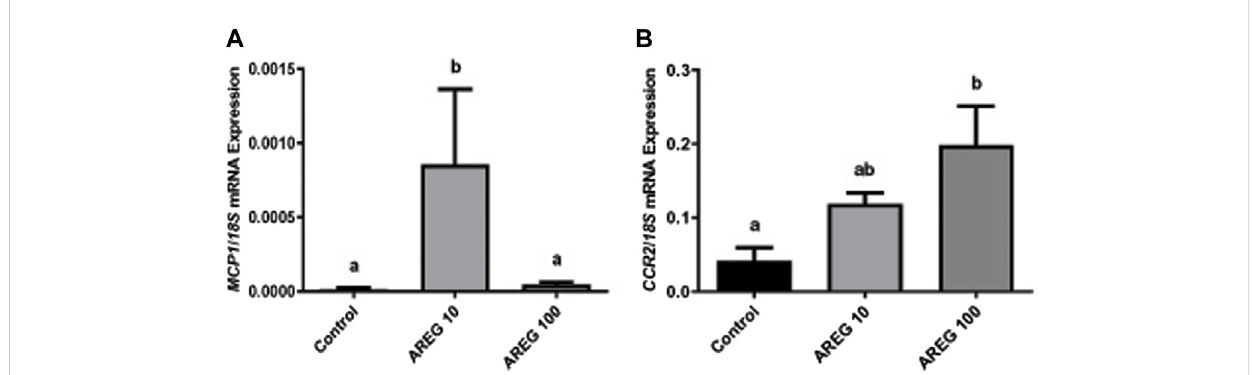
FIGURE 2 The mRNA expression of MCP1 and CCR2 signi fi cantly increased within the COC in the presence of recombinant AREG. Normalized MCP1 [Panel (A) ],and CCR2 [Panel (B) ],mRNAexpressionlevels(mean±SEM,n=5 – 6COCspergroup)withintheCOCafter3 hofcultureinthepresenceorabsence of recombinant AREG (10 or 100 ng/mL), assessed by qRT-PCR. 18S rRNA served as the invariant control for normalization. Different letters represent signi fi cant differences between groups (ANOVA; p < 0.05). AREG: amphiregulin, MCP1 : monocyte chemoattractant protein-1, CCR2 : chemokine CC-motif receptor type